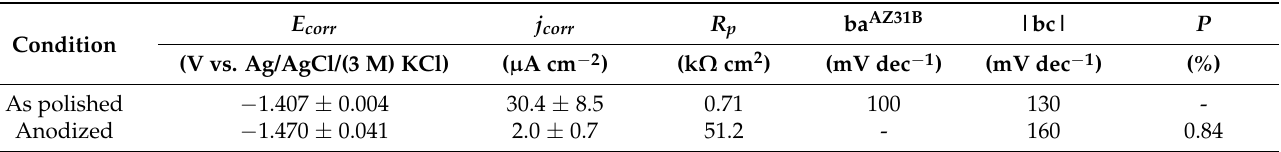
Figure 3. Potentiodynamic polarization curves obtained for the as polished and anodized samples immersed in PBS solution at room temperature. Table 1. Electrochemical parameters obtained from the potentiodynamic polarization curves displayed in Figure 2. The last column indicates the porosity percentage of the anodized